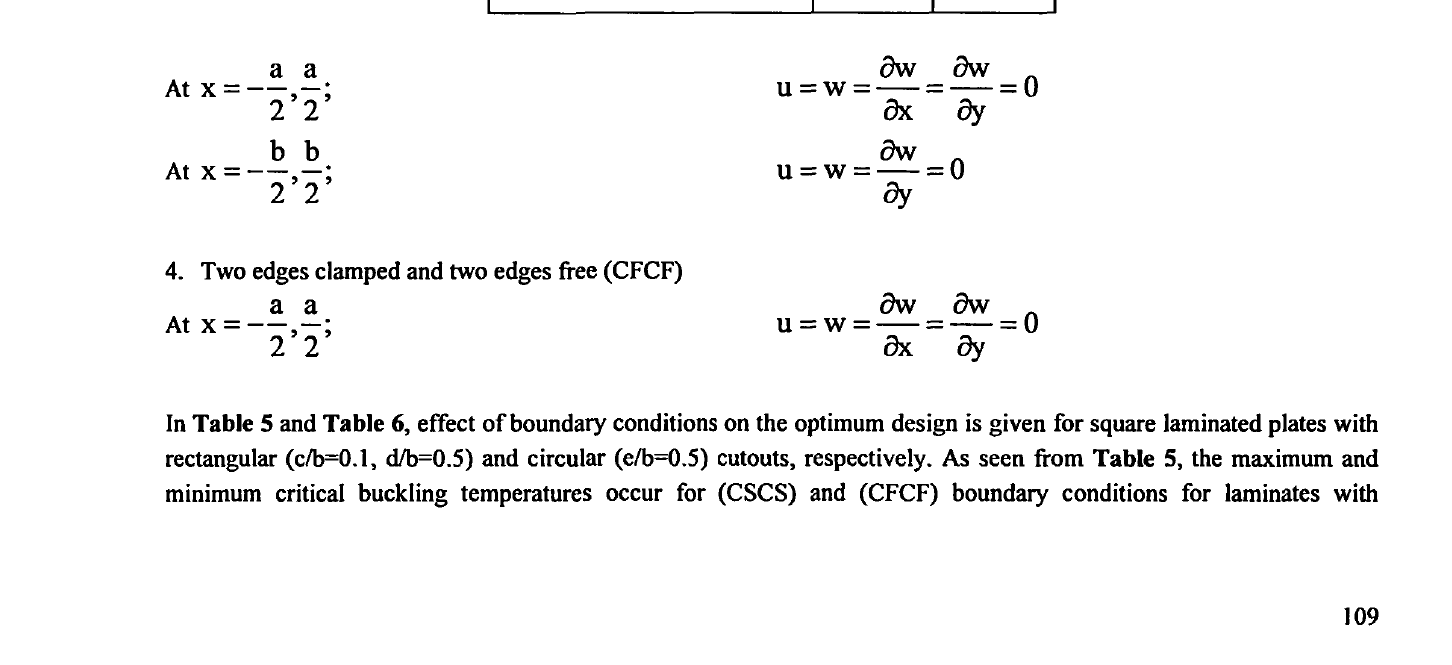
Effect of boundary conditions on the optimum design for square laminated plates with circular cutout